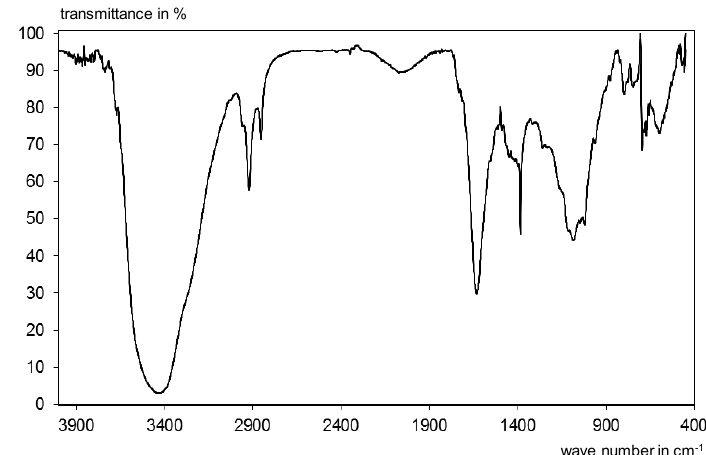
Figure 4. Infrared spectrum of the styrene-butadiene coating of the textile [29].